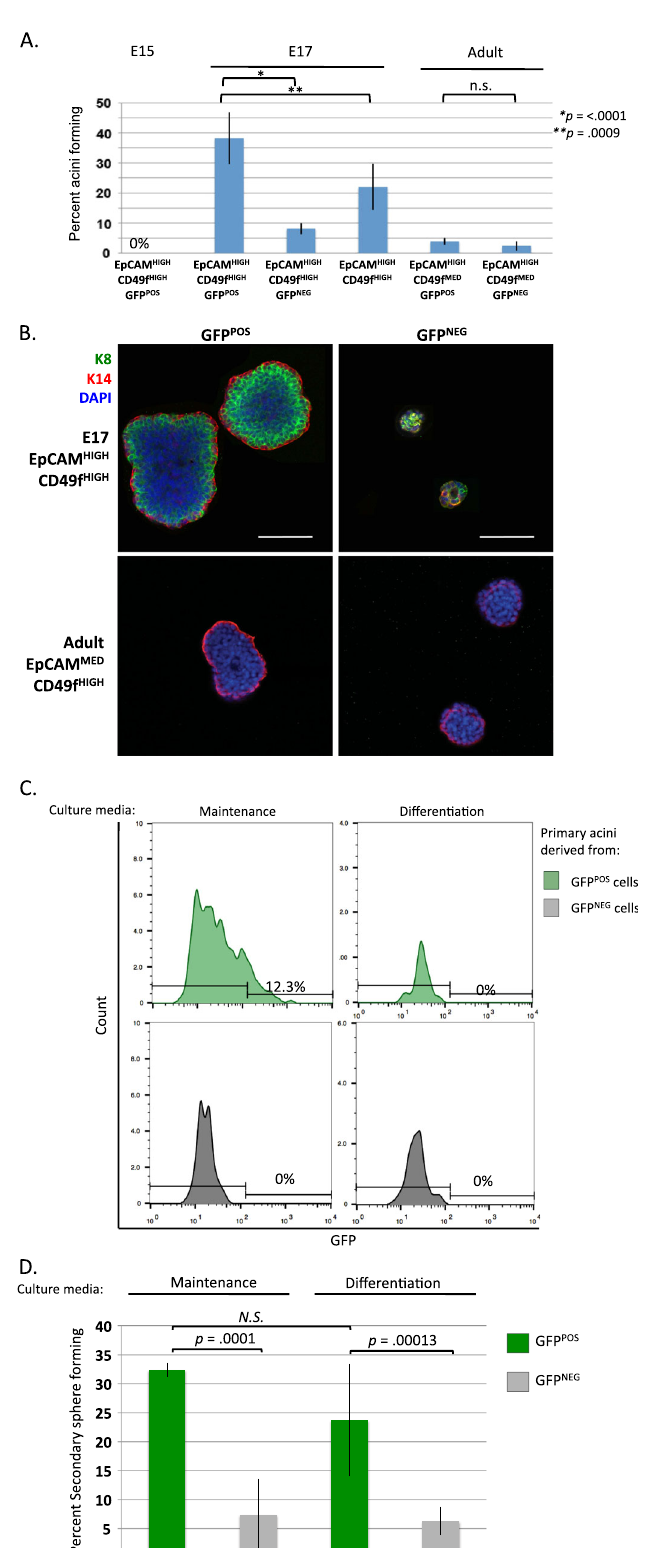
Fig. 2 Lgr5 expression enriches for fMaSC activity in vitro. a Single cells were prepared from mammary glands of Lgr5KI mice at stages E15, E17, and adult, and wild-type mice at E17. EpCAM POS ; CD49f POS cells were then sorted based on GFP expression and plated in 3D culture media containing 2% Matrigel. After 1 week, the percent of SFCs was determined by the number of spheres counted per the number of cells plated. Percent SFC is reported as averages of biological replicates and error bars represent standard deviations from fi ve separate experiments, each with at least three technical replicates. b GFP POS and GFP NEG colonies from stages E17 and adult were stained for Keratin 8 (K8, green ), Keratin 14 (K14, red ), and DAPI ( blue ). Bar represents 100 μ M. Images are representatives of 20 spheres for each genotype over two separate experiments. c Primary spheres derived from GFP POS or GFP NEG cells in the E17 rudiment and cultured in either maintenance or differentiation media were dissociated into single cells and live cells were measured for GFP expression using FACS. The percentage of cells that were GFP positive ( green ) was measured by designating a threshold above which cells dissociated from wild-type spheres measured zero, and is the average percentage of two separate experiments. d Dissociated primary spheres described in c were serially re-plated into their respective media and secondary sphere formation was quanti fi ed 7 days later. Percent SFC is reported as averages of biological replicates and error bars represent standard deviations from three separate experiments, each with at least three technical